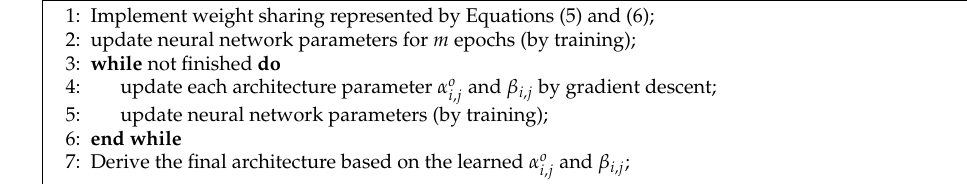
Figure 6. The algorithm steps of Darts.